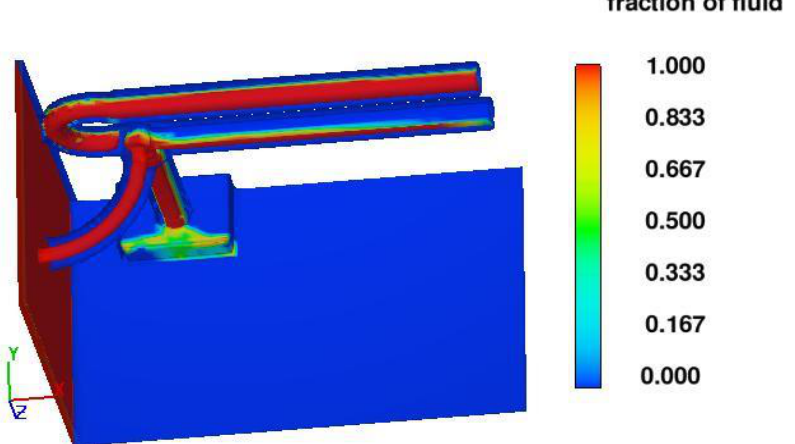
Figure 5. Backflow into the A basin caused by surges in the E–D and E–C water supply line. Figure from [2], pp. 291–292.